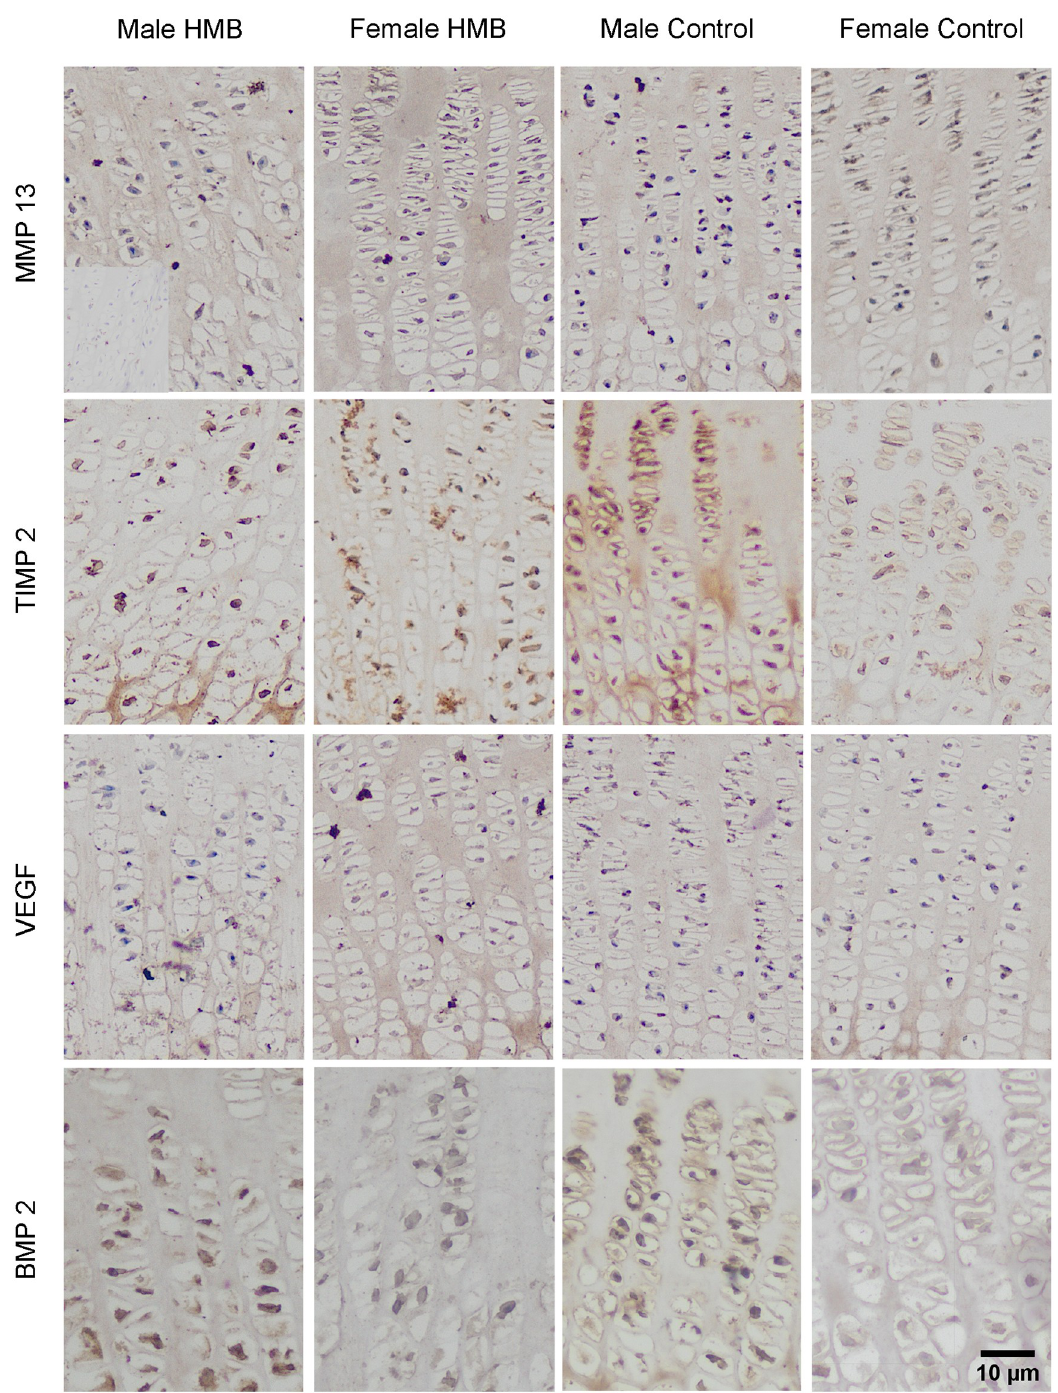
Fig 3. Immunohistochemical analysis of the immunolocalization the MMP13 (matrix metalloproteinase 13), the TIMP2 (tissue inhibitor of metalloproteinases 2), the VEFG (vascular endothelial growth factor) and the BMP2 (bone morphogenetic protein 2) from the humerus growth plate cartilage. Representative images immunohistochemical analysis carried out on the formaldehyde-fixed from the humerus growth cartilage of newborn piglets.